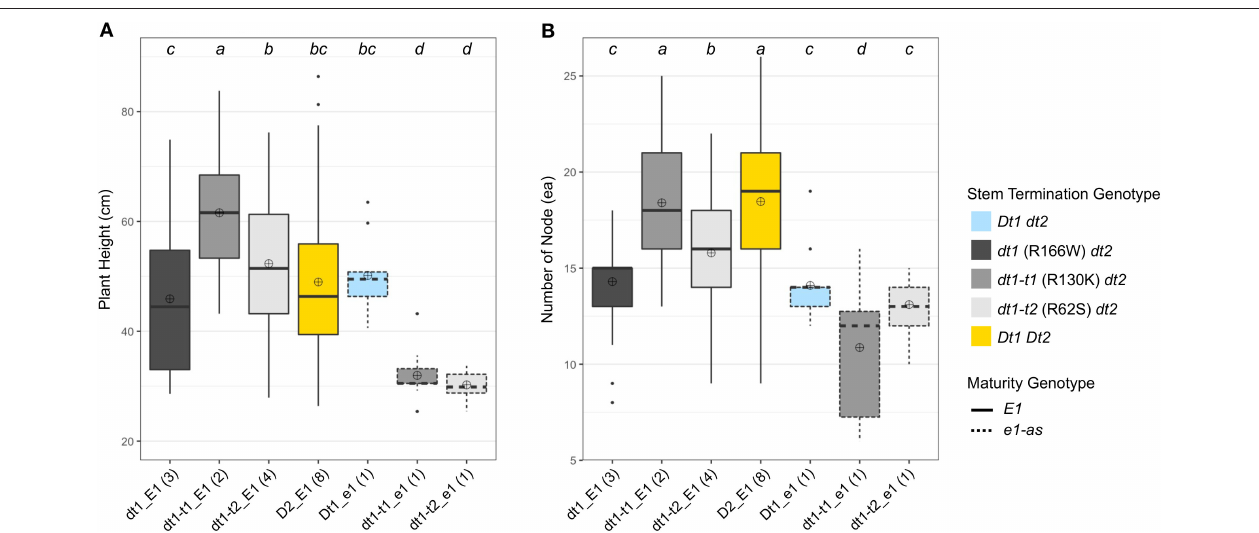
FIGURE 3 | Boxplots of plant height and number of nodes depending on genotype categories examined in 2020 at Knoxville, TN (20TN). A total of 20 soybean lines with each allele combination for genes related to stem termination type and maturity were evaluated. The colors of each box were designated based on the allele status of the two genes, conferring stem termination type, Dt1 and Dt2 . The outlines of each box were designated based on the allele status of the E1 maturity gene. Fourteen soybean lines under three genotype categories, dt1-t1_E1, dt1-t2_E1, and Dt2_E1, were experimental lines from KB17-16 (F 3 : 5 ), KB17-17 (F 3 : 5 ), and either KB17-7 or KB17-8 RIL populations (F 4 : 6 ), respectively. The other six soybean lines were control cultivars. Each genotype category has an unequal number of soybean lines, and the number of lines was written in parentheses beside each genotype category. The plant height and the number of nodes were measured from ten individual plants per plot. ⊕ in each box represents mean values of each genotype category. The genotype categories marked with a common lower-case letter indicate that the means are not significantly different ( p = 0.05) according to Fisher’s Least Significant Difference (LSD) procedure. (A) Displays the distribution of final plant height at maturity in cm. (B) Shows the distribution of number of nodes counted on the main stem at maturity.